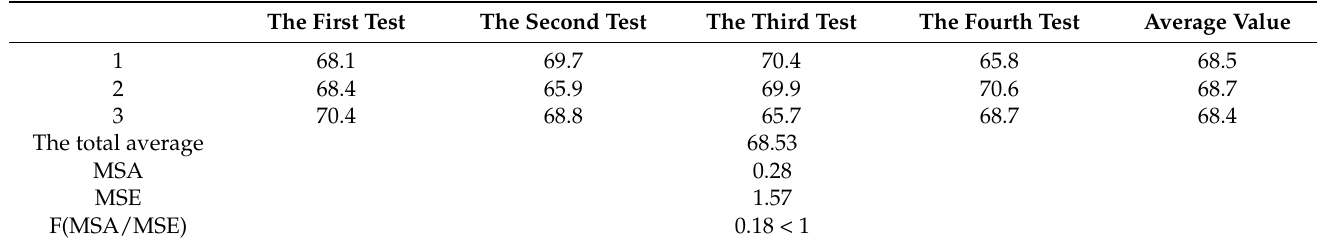
Table 5. Analysis of variance for whiteness.